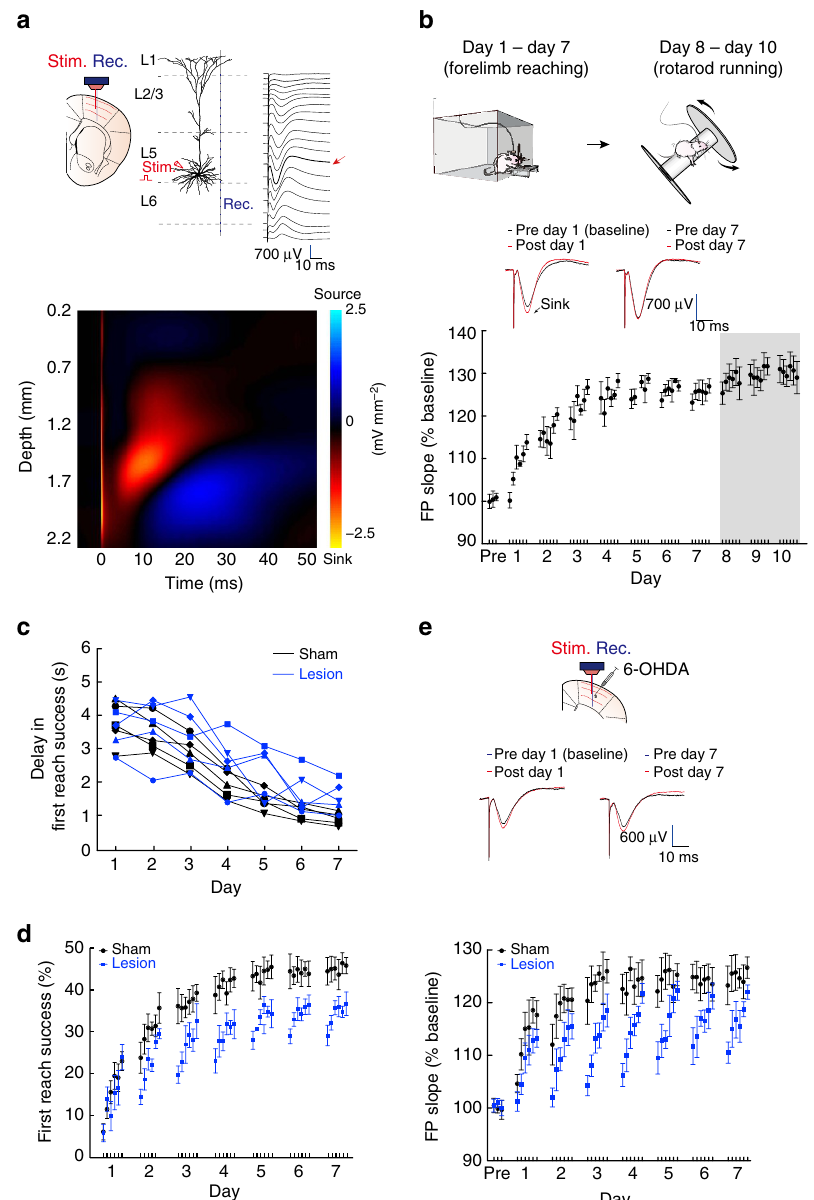
Figure 7 | Local dopamine depletion impaired training-induced LTP of synaptic inputs. ( a ) Top, averaged traces of field potentials (FPs) evoked in vivo at multiple sites from L1 to L6 of M1, recorded via 20 recording contacts in a linear microprobe (Rec.). The stimulating electrode (Stim.) was placed at L5, which could activate synaptic inputs to the basal dendrites. Arrows indicated typical FPs recorded at target deep layer 5. Bottom, current source density profiles corresponding to the laminar FPs evoked by stimulating at L5. By activating inputs targeting basal dendrites, the early, negative FP recorded in L5 was generated by direct inward current (that is, the sink, yellow/red). This feature was highly consistent among different animal subjects. ( b ) Top, FPs were recorded from rats undergoing 7 days of forelimb reaching task, followed by 3 days of rotarod running task. Bottom, potentiation of stimulation evoked-FPs slope when activating basal dendritic inputs in L5. Representative traces of the FPs on days 1 and 7 (pre- and post-training) are shown. All bars represent the mean ± s.e.m (five rats). ( c ) Learning-associated shortening in delay of first reach attempt in sham-operated (black, five rats) and 6-OHDA lesioned animals (blue, five rats). Sham group: mean ± s.d. of delay on day 1: 4.416 ± 0.783s, day 3: 3.362 ± 0.588s, P ¼ 0.038; day 7: 1.118 ± 0.216s, P ¼ 0.006, all compared to day 1, one-way repeated measures ANOVA, 5 rats; Lesioned group: mean ± s.d. of delay on day 1: 3.663 ± 0.676s, day 4: 2.631 ± 0.849s, P ¼ 0.065; day 5: 2.376 ± 0.778s, P ¼ 0.048; day 7: 1.587 ± 0.463s, P ¼ 0.019, all compared to day 1, one-way repeated measures ANOVA, 5 rats. ( d ) Comparison of motor skill performance between sham-operated (black, five rats) and 6-OHDA lesioned (blue, five rats) animals. Data are represented as mean ± s.e.m. In contrast to the sham group, the first reach success rate achieved after each day’s training by the lesioned animals was not well maintained in the next day. ( e ) Comparing to sham-operated group (black, five rats), with local dopamine depletion restricted to M1 (blue, five rats), learning-induced potentiation of FPs could not be maintained. Data are represented as mean ±